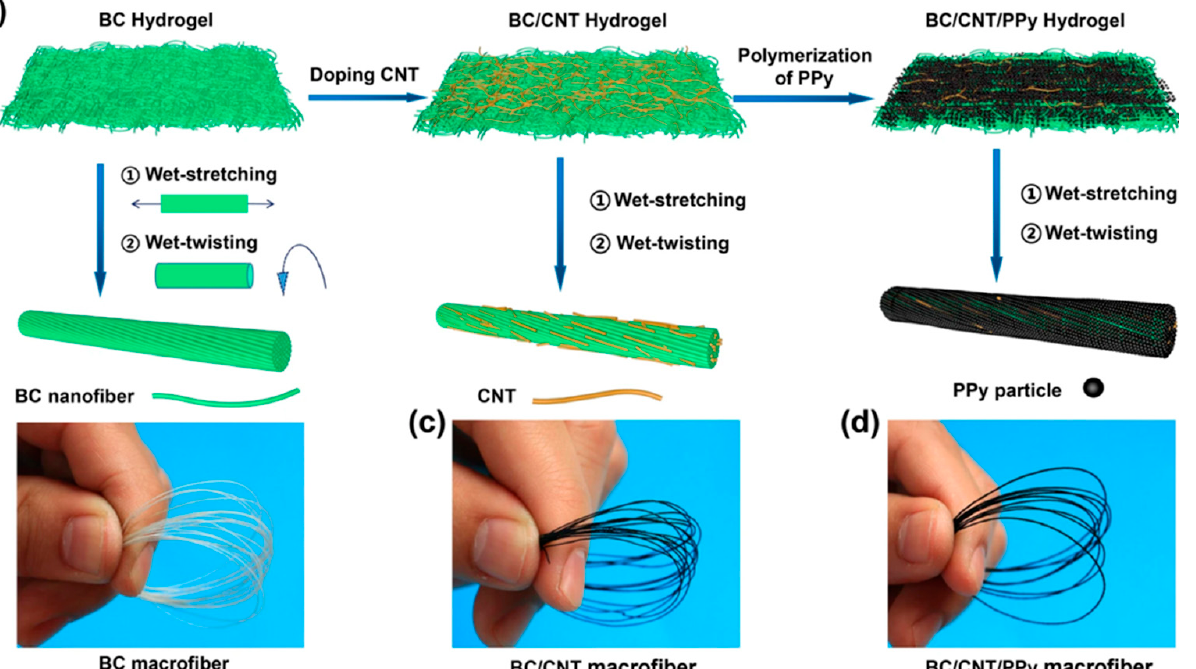
Figure 5. ( a ) Schematic view of the main components and materials of the fabric ‐ based TENG de ‐ signed by Hu et al. [155]; ( b ) two operating modes of the fabric ‐ based TENG, ( i ) contact ‐ separation